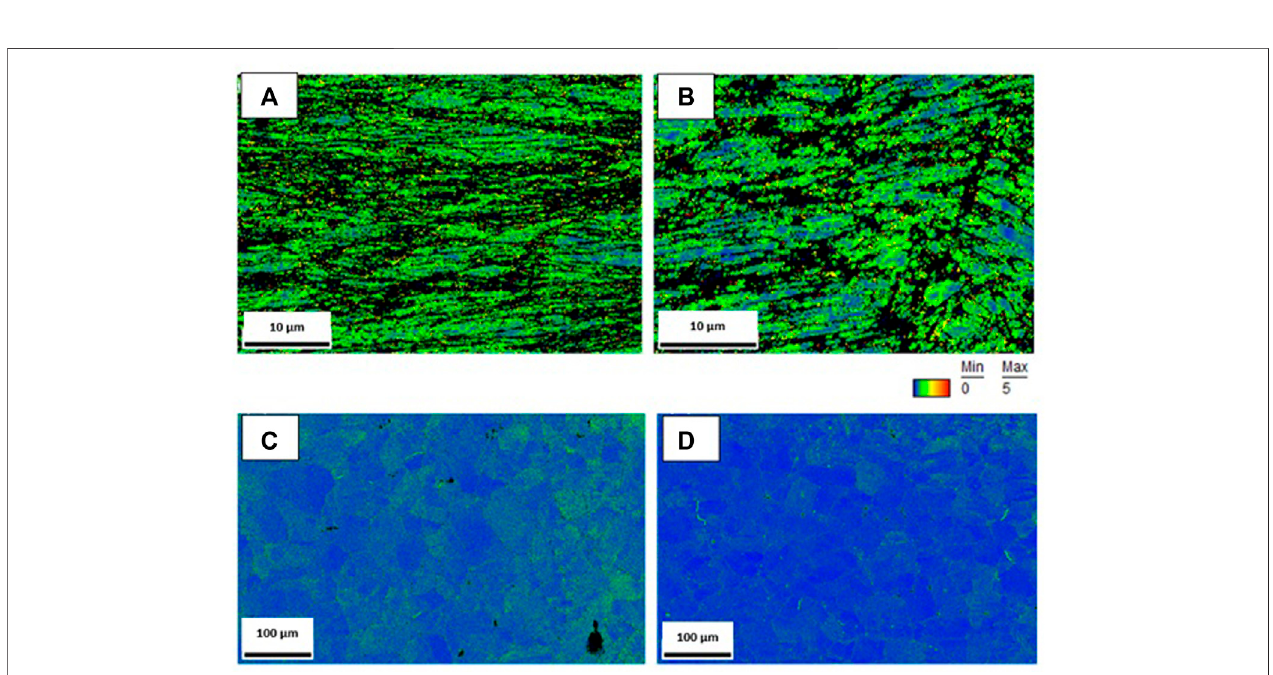
Frontiers in Materials |